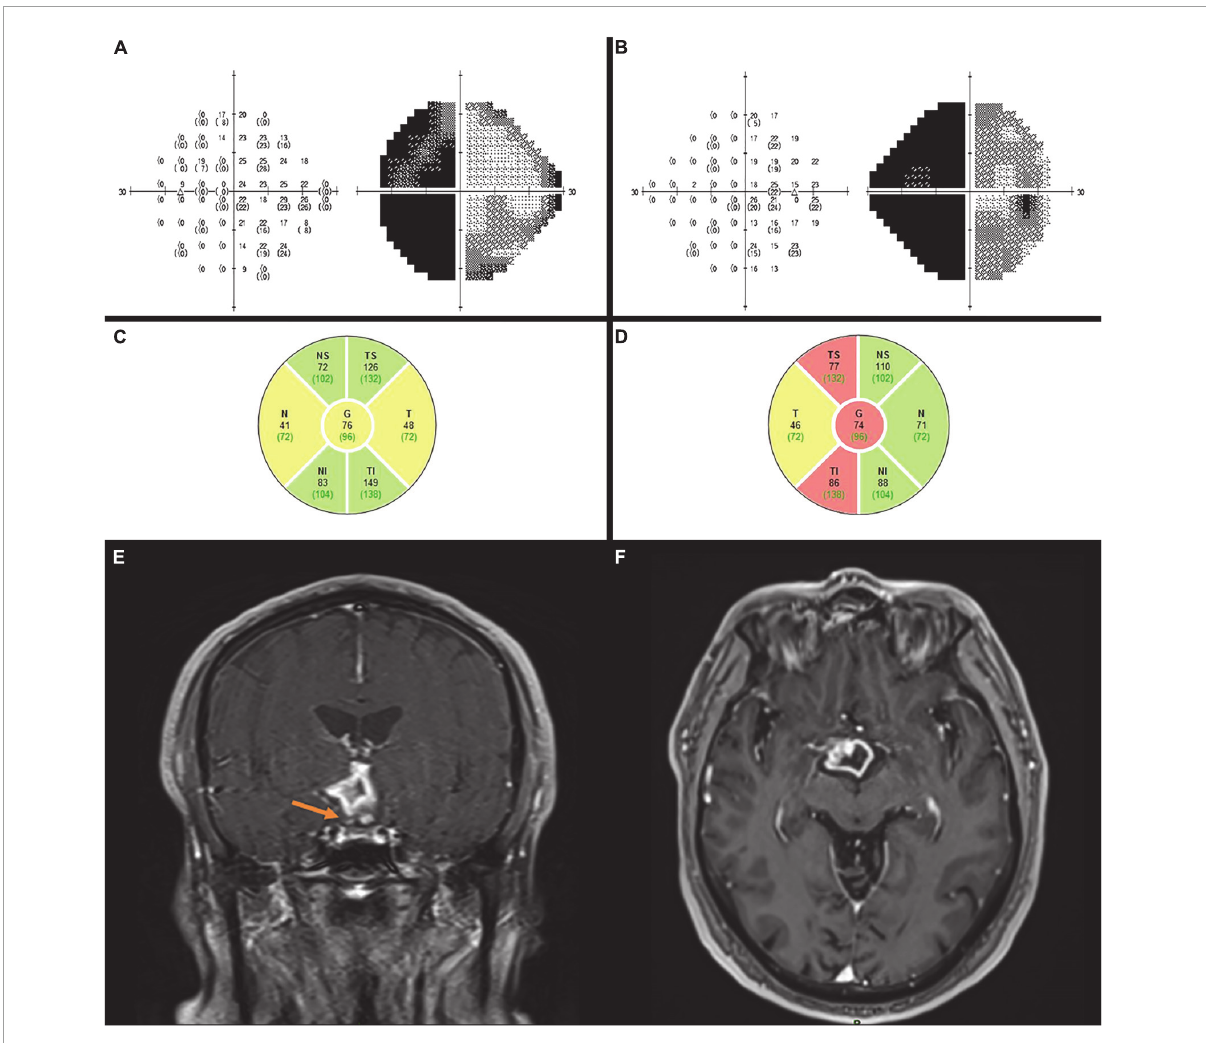
FIGURE2 Case 2. Automated perimetry shows left homonymous hemianopia in the left (A) and right (B) eye. OCT demonstrates RNFL thinning in the left nasal and temporal (C) and right superior and inferior quadrants (D) . MRI T1 coronal (E) and axial imaging. (F) After contrast show a ring enhancing lesion involving the hypothalamus and right optic tract (arrow) causing posterior compression of the chiasm consistent with low -grade